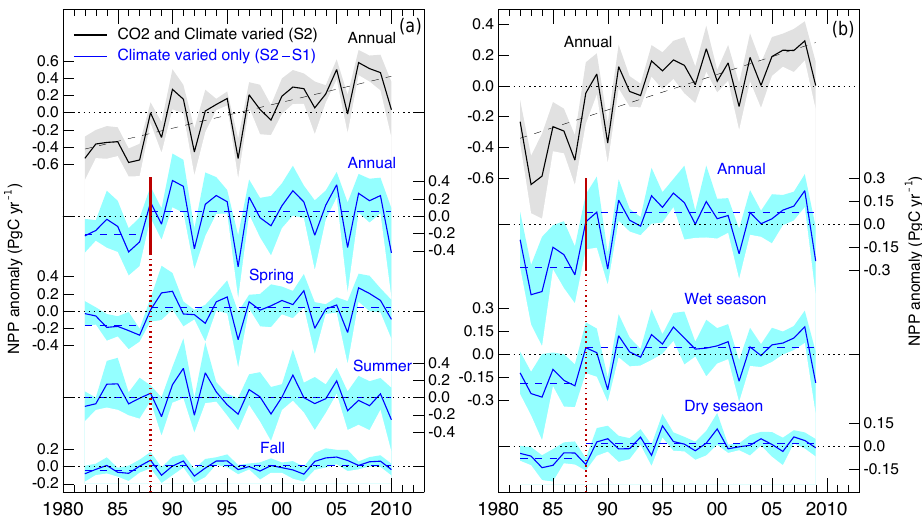
Figure 3. Temporal changes in continental process-based NPP based on nine terrestrial biosphere models. Panels show annual and seasonal NPP anomalies for the (a) northern Eurasian and (b) North African focus regions, based on ensembles of nine biosphere models that participated in the recent TRENDY model intercomparison study (Sitch et al., 2015). In the annual case, results for two sets of model simulations are shown: one in which climate and CO 2 as model drivers were varied (S2) and another one that only takes into account the effect of climate variations (S2–S1; see Sect. 2). All anomalies are relative to the 1982–2010 overlapping satellite era to facilitate comparisons with the data-driven NPP simulations (see Fig. 2). Mean ensembles were formed based on anomalies in the single TRENDY models to emphasize temporal changes in NPP and to suppress uncertainties arising from model differences in magnitudes. Shaded contours represent 1 σ uncertainties corresponding to the spread in the single TRENDY models. The first year of a new regime in annual NPP is outlined (thick dark-red vertical lines; Table S1), and the means in NPP anomalies prior to and after the shift are also shown (dashed lines). In panel (b) , the last data point for the year 2010 is omitted since tropical rainfall input data for the TRENDY runs were erroneous for that year (S. Sitch, personal communication,